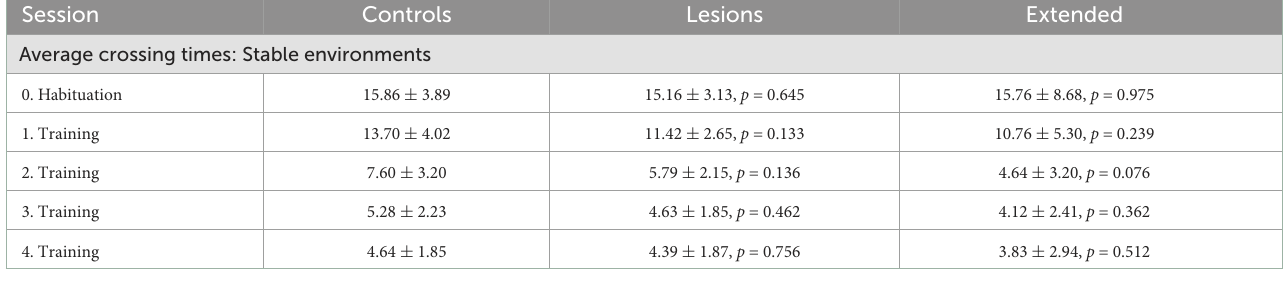
TABLE 2 Average crossing times (seconds) of each group for all sessions with stable obstacles (mean ± standard deviation, p -values report Student’s unpaired t -test against the control group). Session